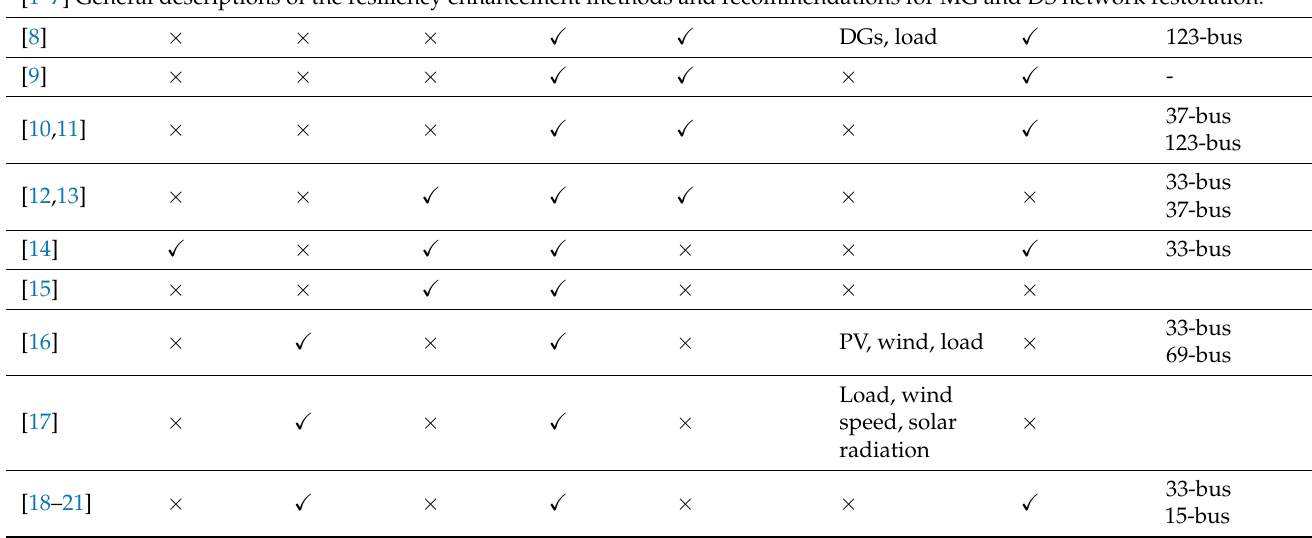
Table 1. A comparison of the relevant works in the literature. Ref.